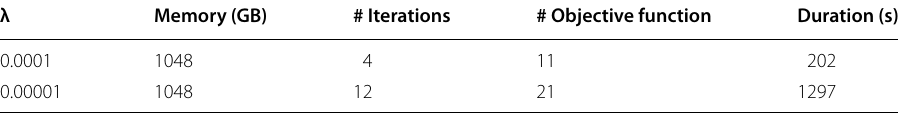
Table 4 Results description for wikipedia‑medium